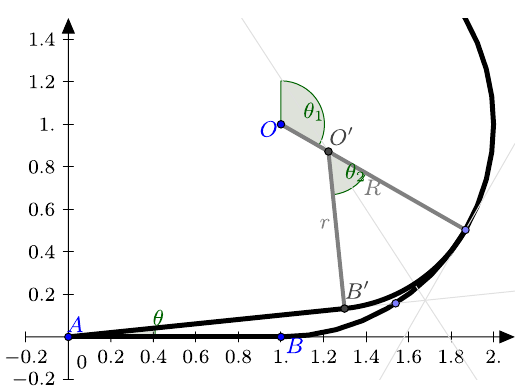
FIG. 7. Scheme of the bypass geometry. The IP line AB has been purposely stretched, being actually ∼ 1 = 5 of the arc radius.